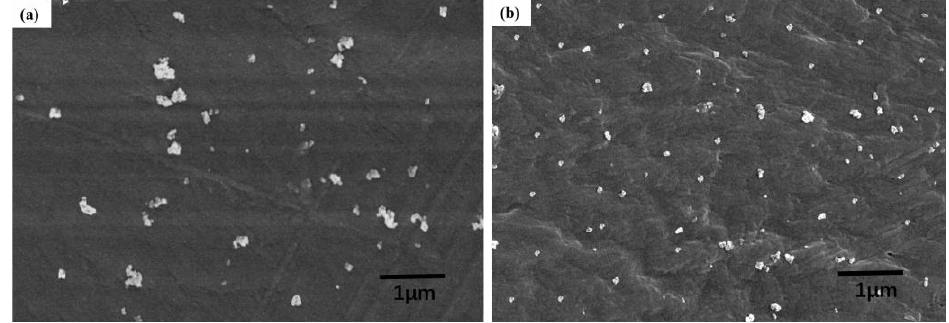
Figure 5. Field emission scanning electron microscopy (FESEM) images of composites ( a ) PET/SiO 2 ; ( b ) PET/SiO 2 –TEG–PET. Table 3. Content of elemental microanalysis (SEM-EDS) of SiO 2 @Tb 3+ (PET–TEG) 3 Phen.